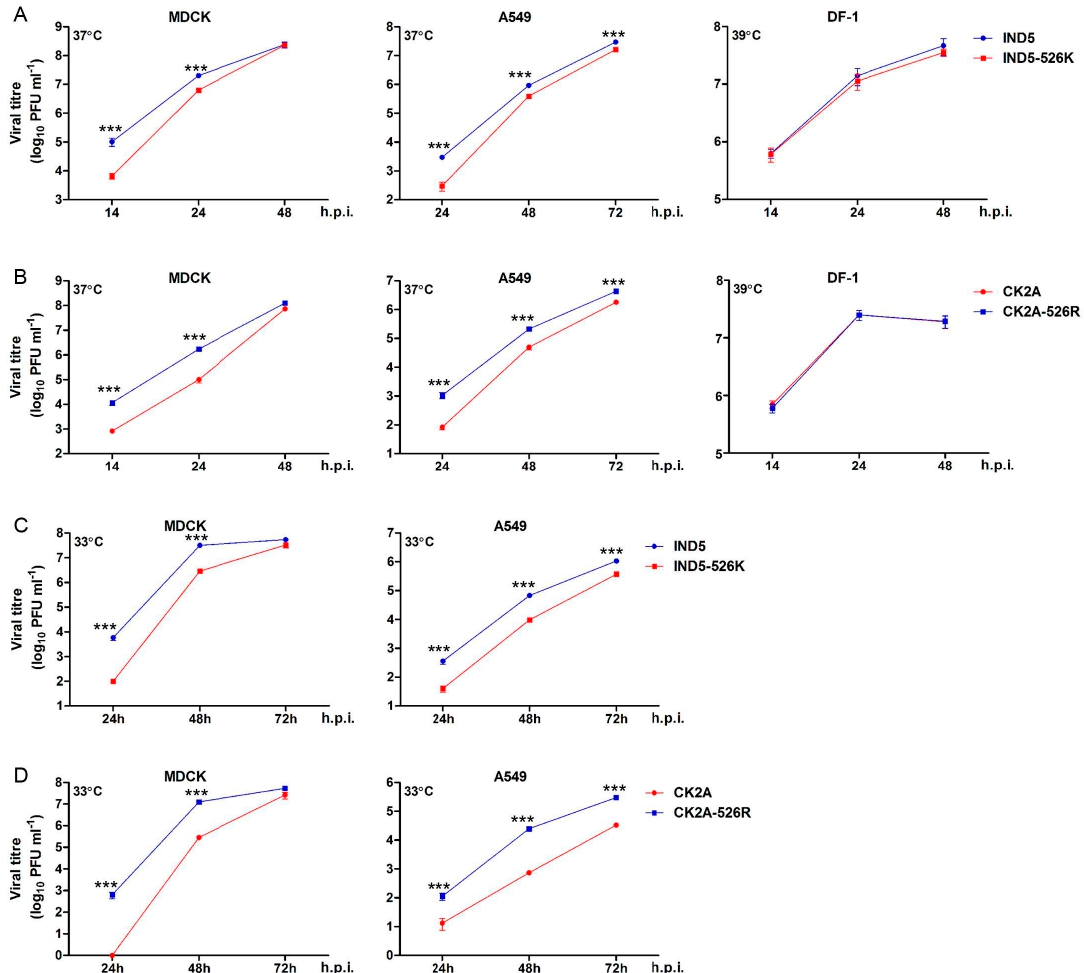
Figure 3. Growth kinetics of H5N1 viruses in mammalian and avian cells. Reverse genetic (RG) versions of the human H5N1 isolate, A/Indonesia/5/05 (IND5), and a mutant virus containing 526K-PB2 (IND5-526K) were used to infect MDCK and DF-1 cells at an MOI of 0.001, or A549 cells at an MOI of 0.01 ( A ). Similarly, RG versions of the avian H5N1 isolate, A/Chicken/Indonesia/2A/03 (CK2A), and a mutant virus containing 526R-PB2 (CK2A-526R) were used to infect MDCK and DF-1 cells at an MOI of 0.001, or A549 cells at an MOI of 0.01 ( B ). Growth of IND5 ( C ) and CK2A ( D ) viruses at 33 °C was estimated in MDCK and A549 cells. After adsorption for 1 h, the cells were washed and overlaid with infection medium containing 1 µg/mL of TPCK-trypsin. At the indicated time points, culture supernatants were collected for virus titration by plaque assay in MDCK cells. Data represent mean viral titers from three independent experiments. Error bars represent standard deviation calculated from three separate experiments. Statistical significance was analyzed by one-way ANOVA, corrected by the Bonferroni post test: *** p < 0.001., h.p.i., h post infection.